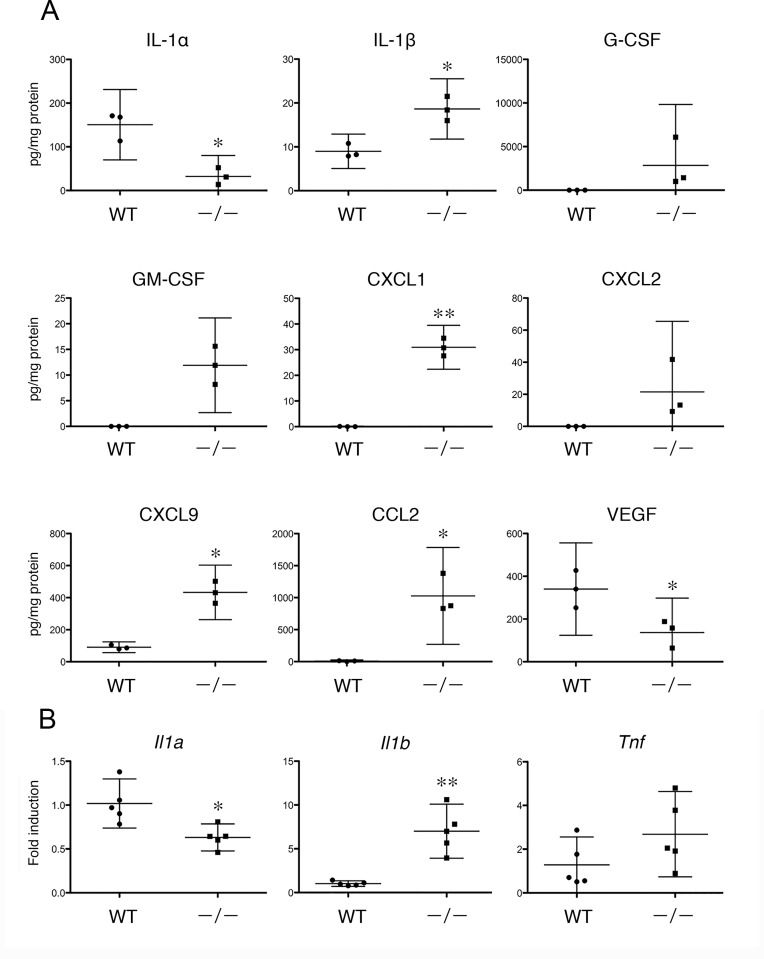
(A) Protein expression of cytokines and chemokines in wild-type and in Tgm1–/–skins. Data were obtained from 3 independent samples of Tgm1–/–(–/–) and wild-type skin (WT) (19.5 dpc pups, n = 3), and fold-inductions of the mean values of expression in wild-type skins are plotted with means and bars representing 95% CI. *, P<0.05; **, P<0.01. (B) Gene expression of Il1a, Il1b, and Tnf in wild-type and in Tgm1–/–epidermis. Data were obtained from 5 independent specimens of Tgm1–/–epidermis (–/–) vs wild-type epidermis (WT) (19.5 dpc pups, n = 5), and fold-inductions of the mean values of expression in wild-type epidermis were plotted with means and bars representing 95% CI. *, P<0.05; **, P<0.01.